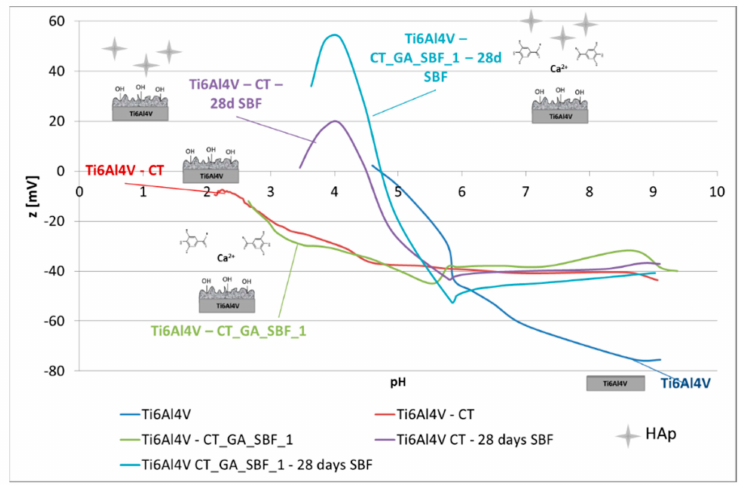
Figure 7. Zeta potential recorded as function of